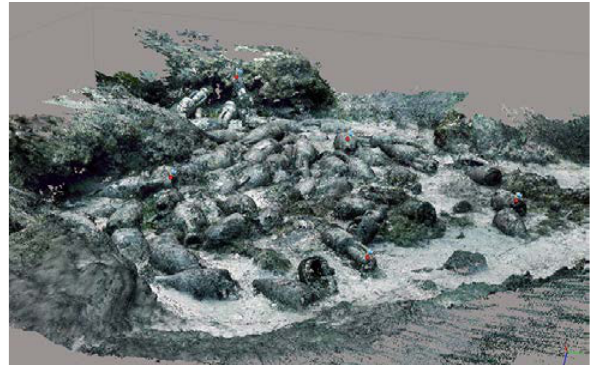
Figure 5. 3D point cloud obtained by processing the image data set